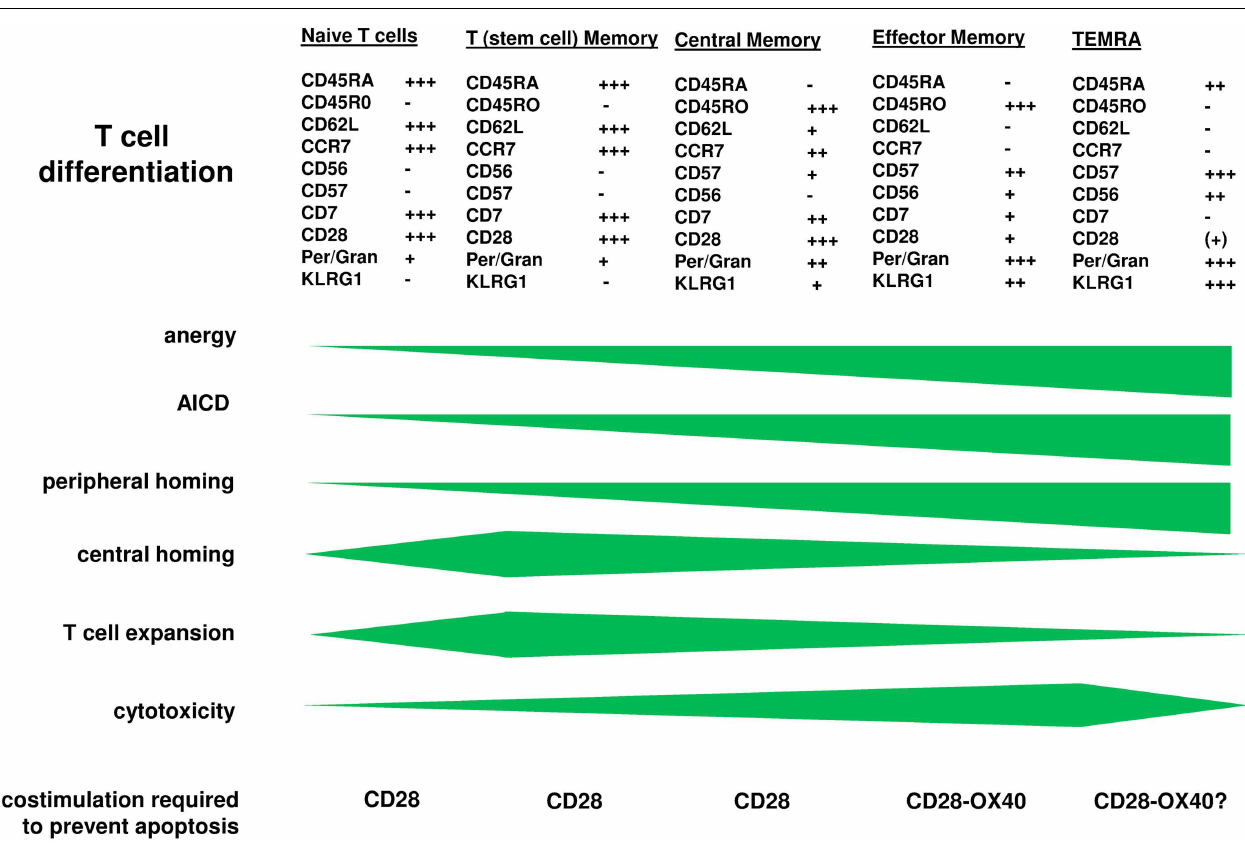
FIGURE 1 |T cell maturation is accompanied by altered functional properties . CAR engineeredT cells progress in maturation when the CAR repetitively engages cognate antigen as physiologically occurs upon TCR/CD28 signaling.While CAR engineered “young” memoryT cells are transferred to the patient, the cells expand and undergo further differentiation leaving effector memoryT cells at the tumor lesion which require additional